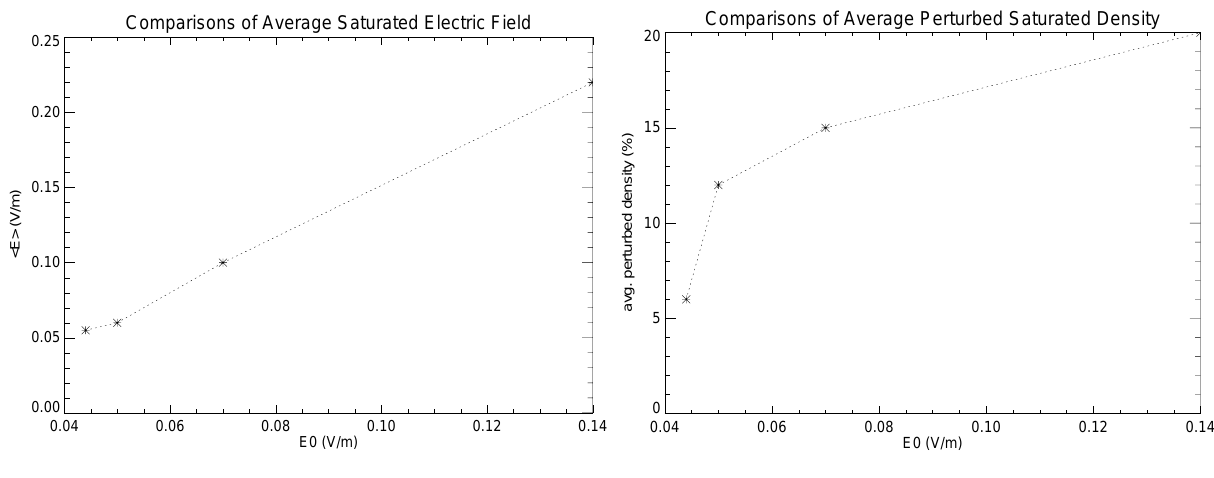
Fig. 3. Saturated RMS electric field and density perturbation levels from four simulations. Left image shows the RMS electric field while the right image shows the RMS of the perturbed density versus driving electric field. Note that the label of the left image, h E i represents h E 2 i 1 / 2 .